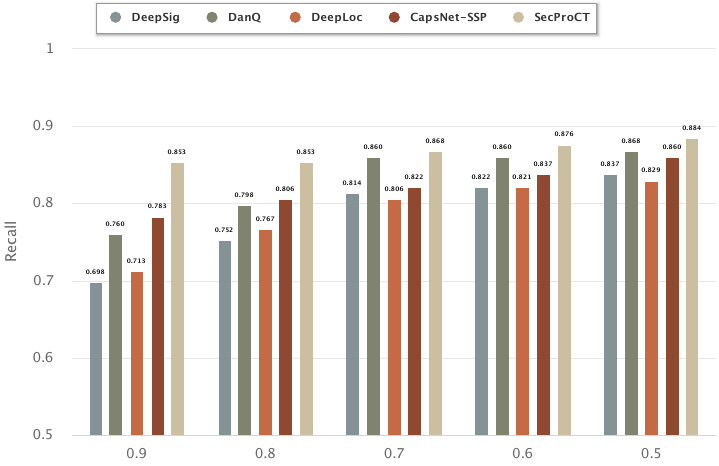
Figure 3. Prediction results of known cancer markers in